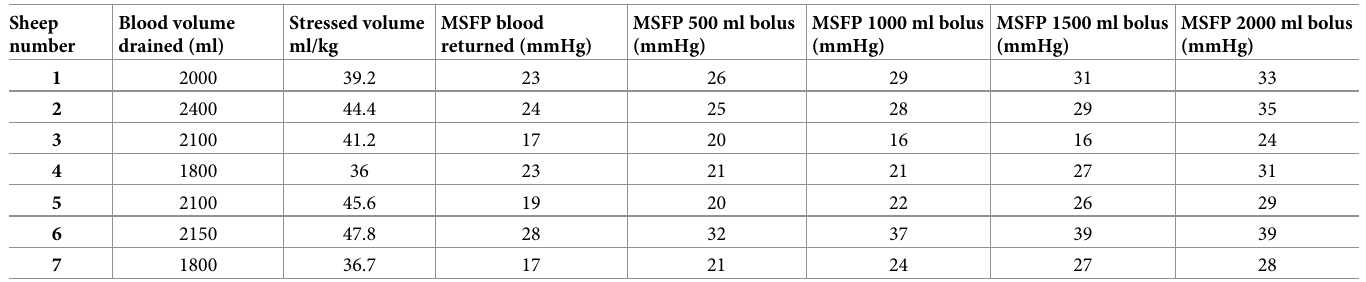
Table 3. Stressed volume and mean systemic filling pressure